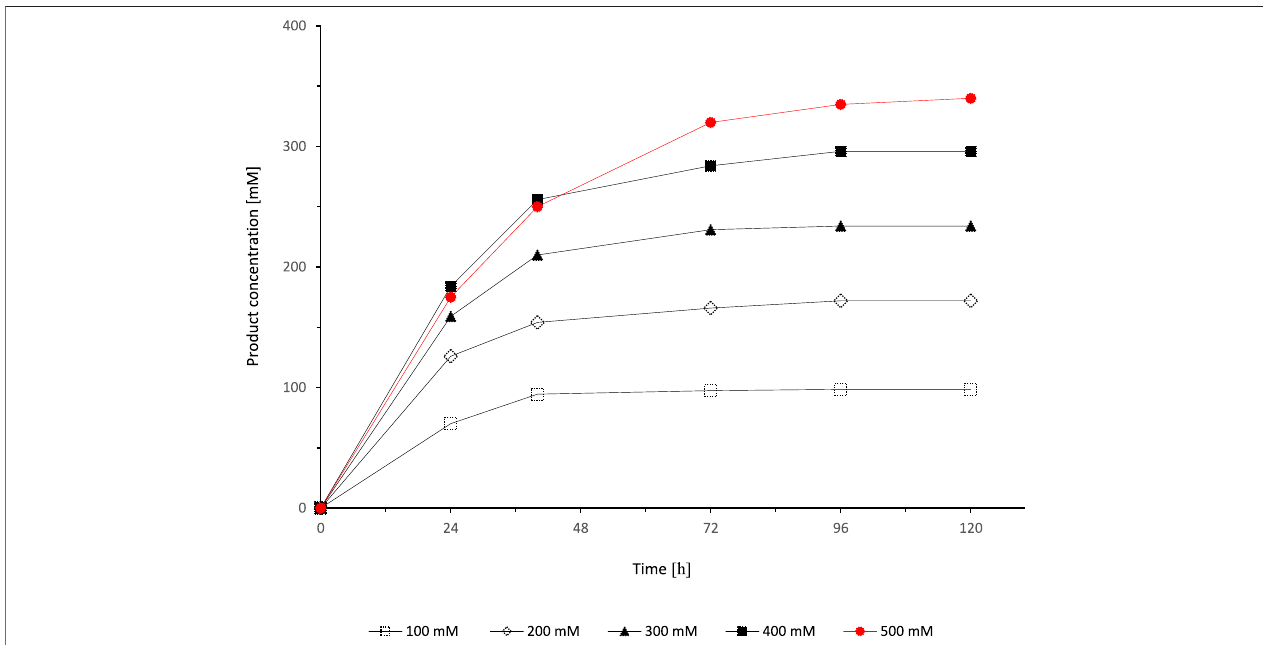
FIGURE 6 | Effect of different substrate concentrations on the Sy ADH catalysed oxidation of rac -heptan-2-ol in a biphasic reaction system. Reaction conditions: [ rac -heptan-2-ol]